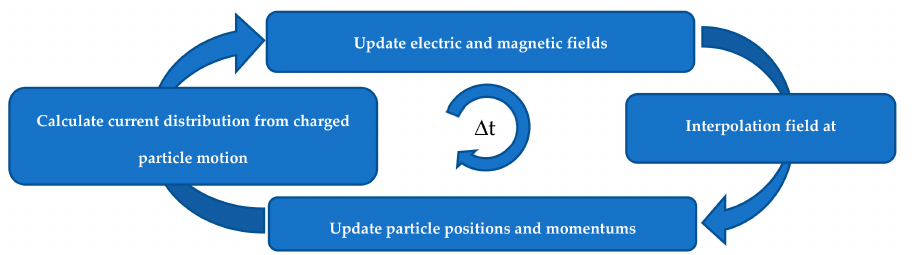
Figure 7. A block diagram of particle-in-cell (PIC) simulation technique.